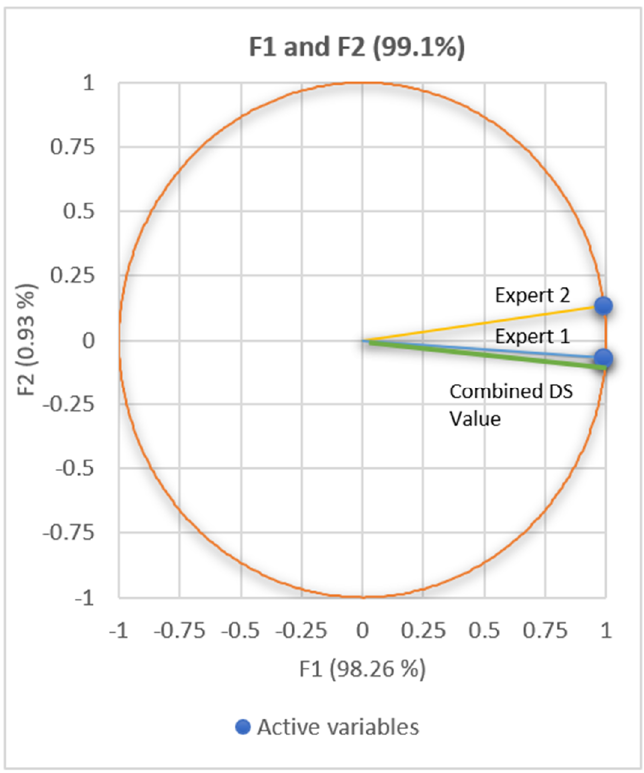
Figure 2. shows the correlation circle with the principal